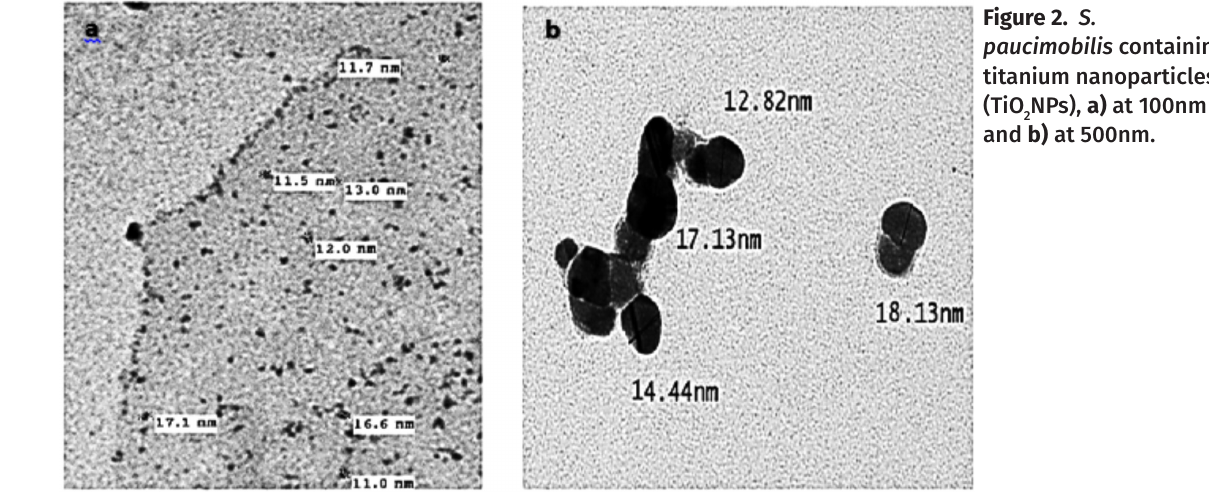
NPs produced by S. paucimobilis after 24 h incubation 2